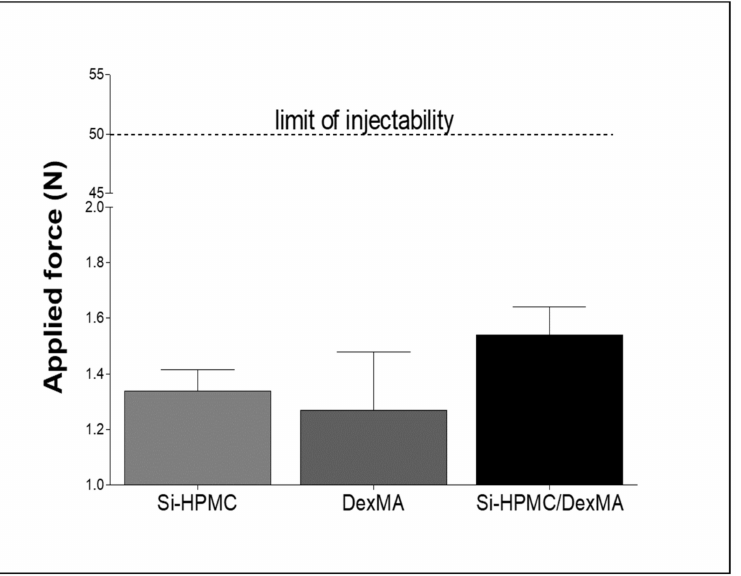
Figure 3. Injectability of Si-HPMC, DexMA, and Si-HPMC/DexMA solutions. The force required to inject 1 mL of each polymer solution through a 3 mL syringe loaded with 1 mL of polymer solution using an 18 G needle. The results are expressed as means ± SEM ( n = 3). Si-HPMC: silanized hydrox- ypropyl methylcellulose, DexMA: dextran methacrylate, Si-HPMC/DexMA: silanized hydroxypropyl methylcellulose/dextran